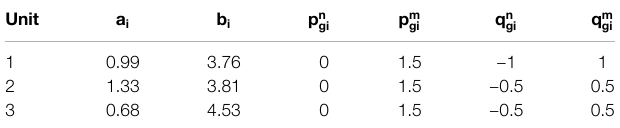
FIGURE 5 | 6-Bus radial network system.